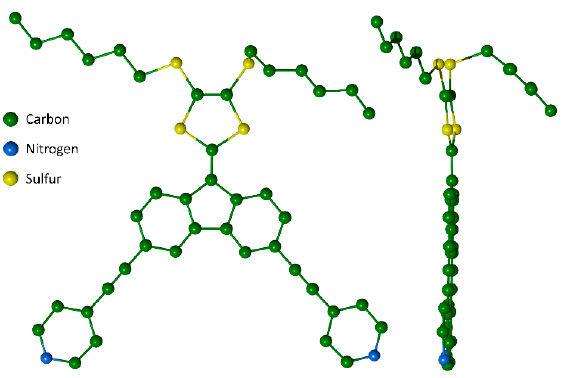
Figure 1. X-ray crystal structure of ligand L4Pyr .